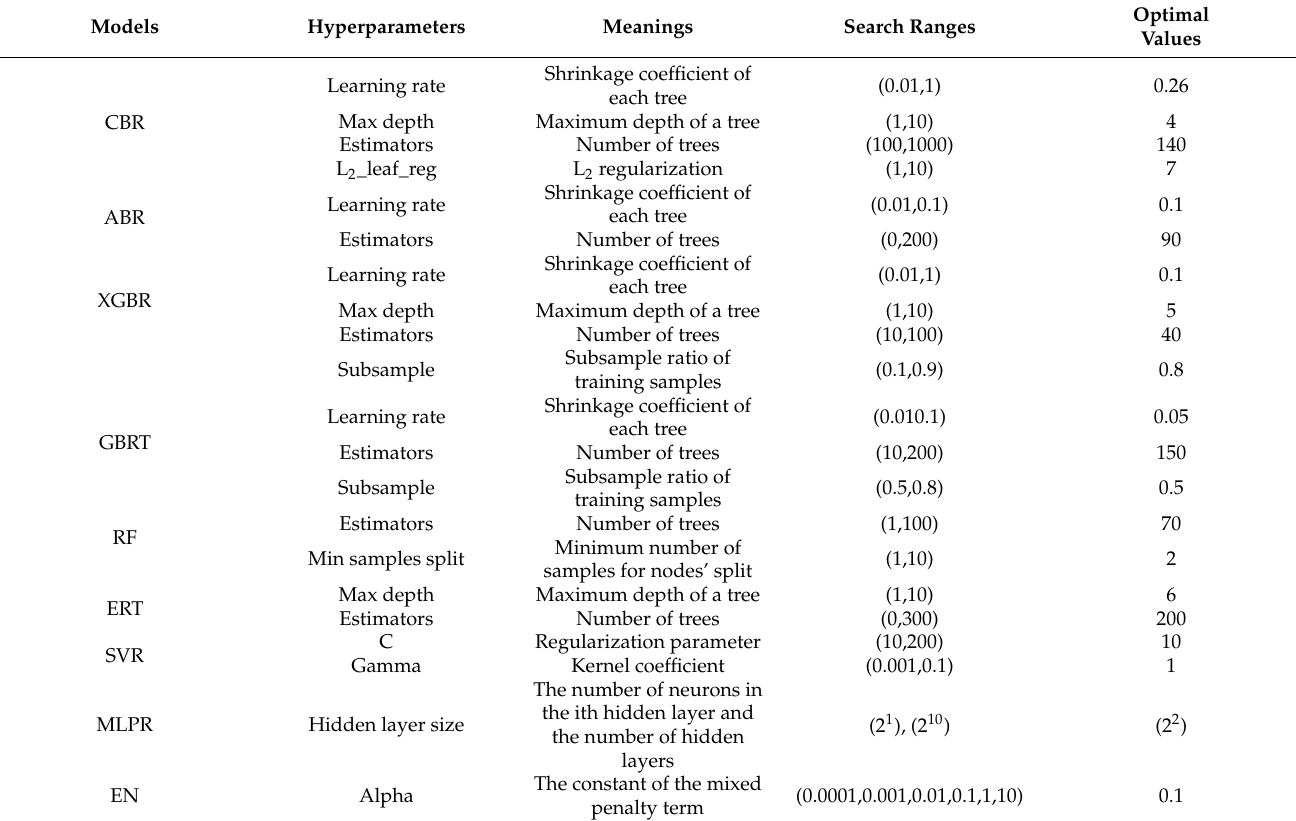
Table 2. Tuned hyperparameters and their settings for each model in the prediction of Chl-a.